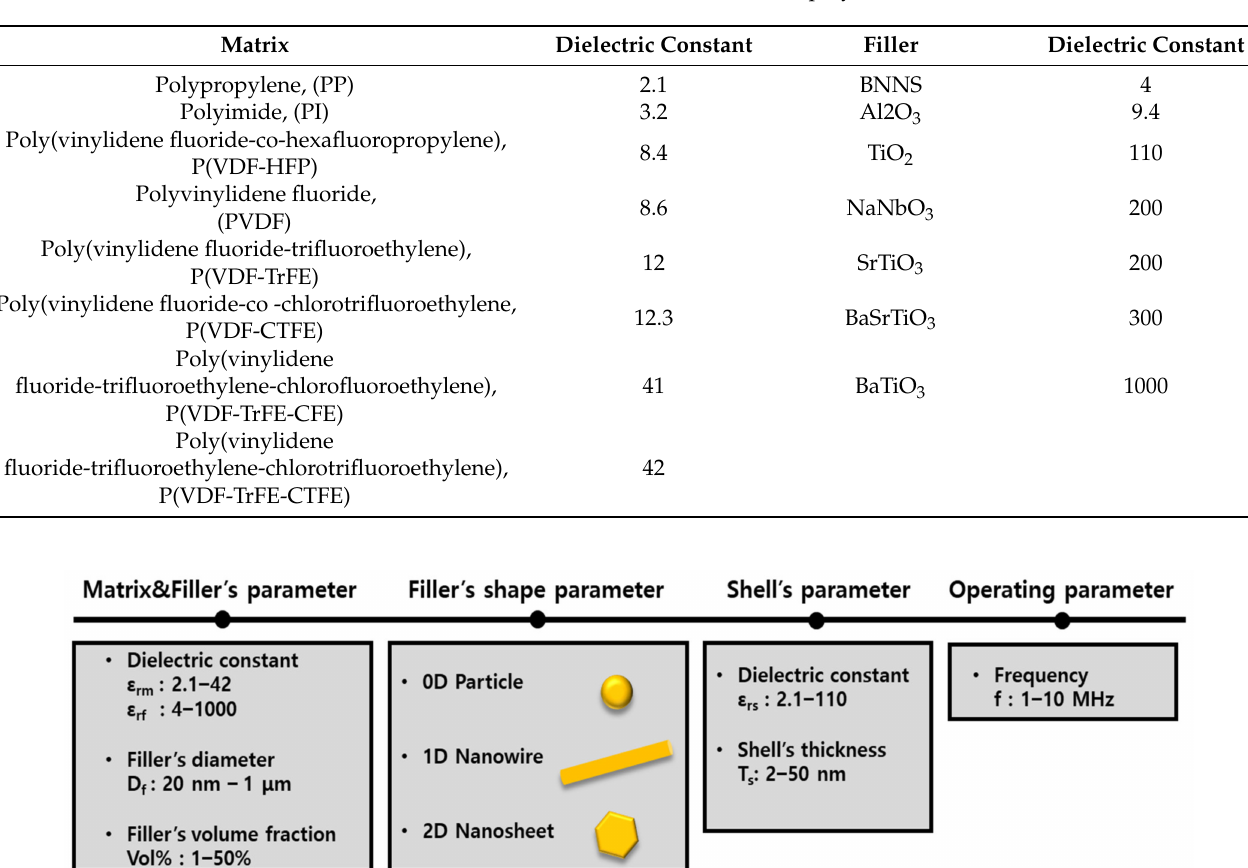
Table 1. The dielectric constant values for different polymer matrixes and nano ceramic fillers.